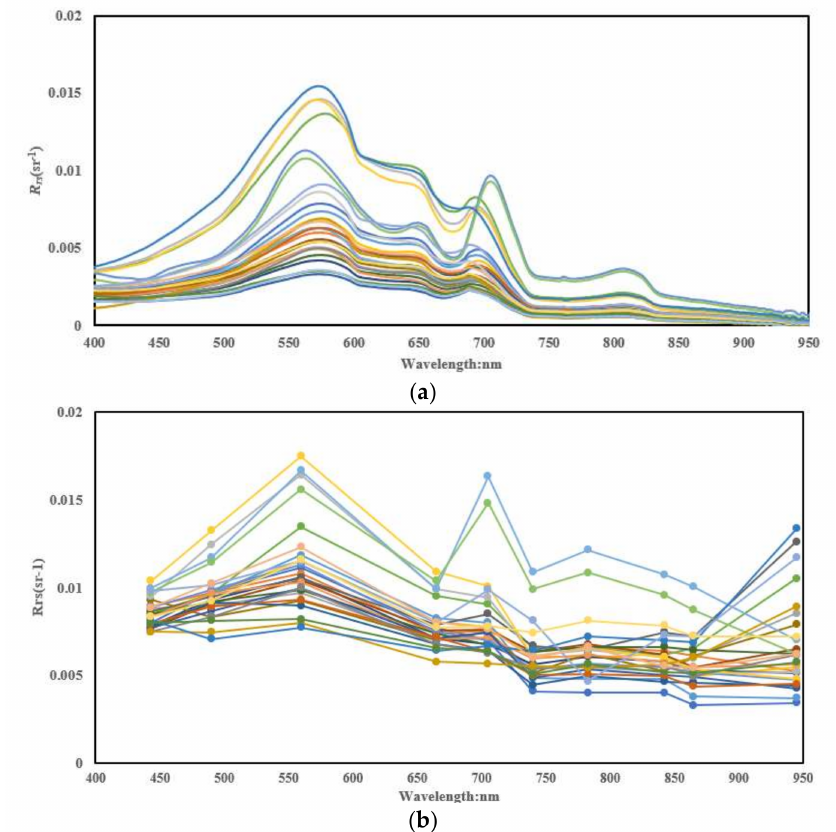
Figure 2. ( a ) In situ remote-sensing reflectance Rrs( λ ) on 21 and 22 May 2019 and ( b ) the equivalent spectral reflectance of Sentinel-2 on 23 May